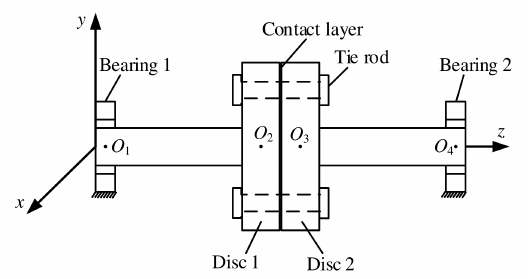
Figure 1. Structure of rod fastening rotor [25].